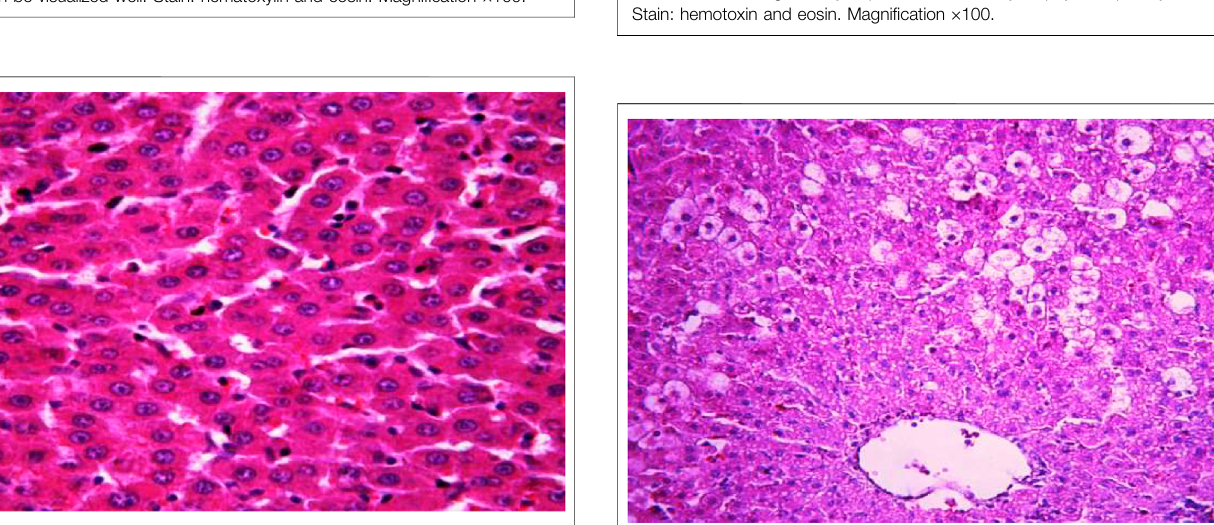
FIGURE 2 | Liver tissue. Negative group. The structure of the liver lobule can be visualized well. Stain: hematoxylin and eosin. Magni fi cation × 100.